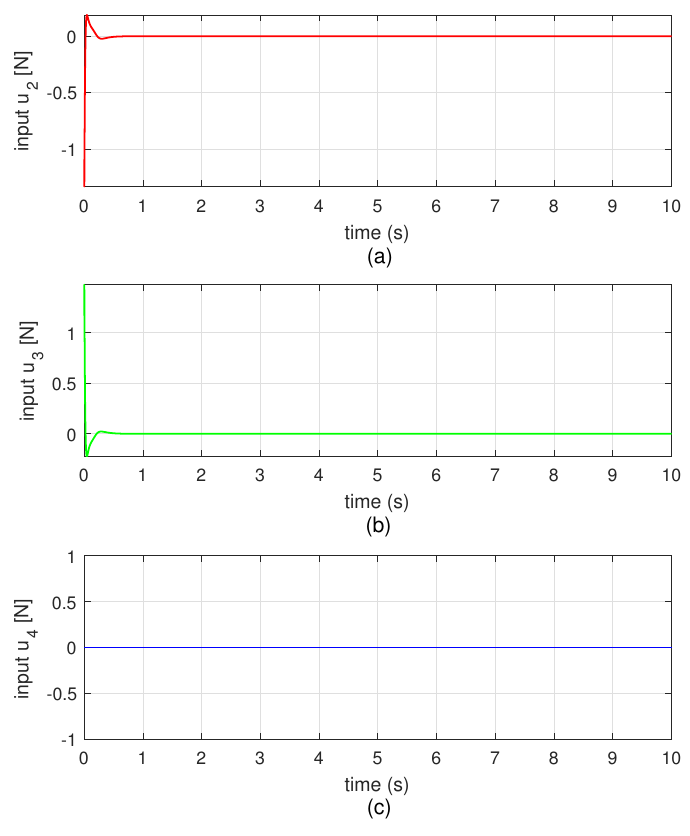
Figure 7. The control inputs for the attitude of a quadrotor: ( a ) u 2 ; ( b ) u 3 ; ( c ) u 4